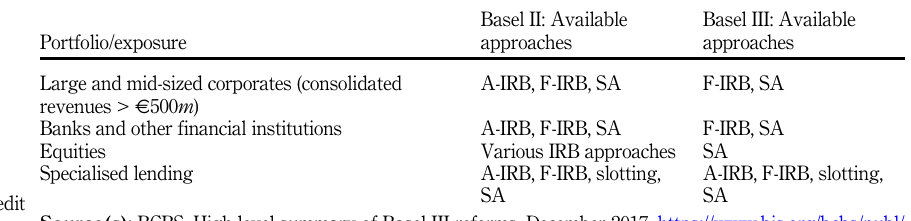
Table 7. Revised scope of credit risk IRB approaches for asset